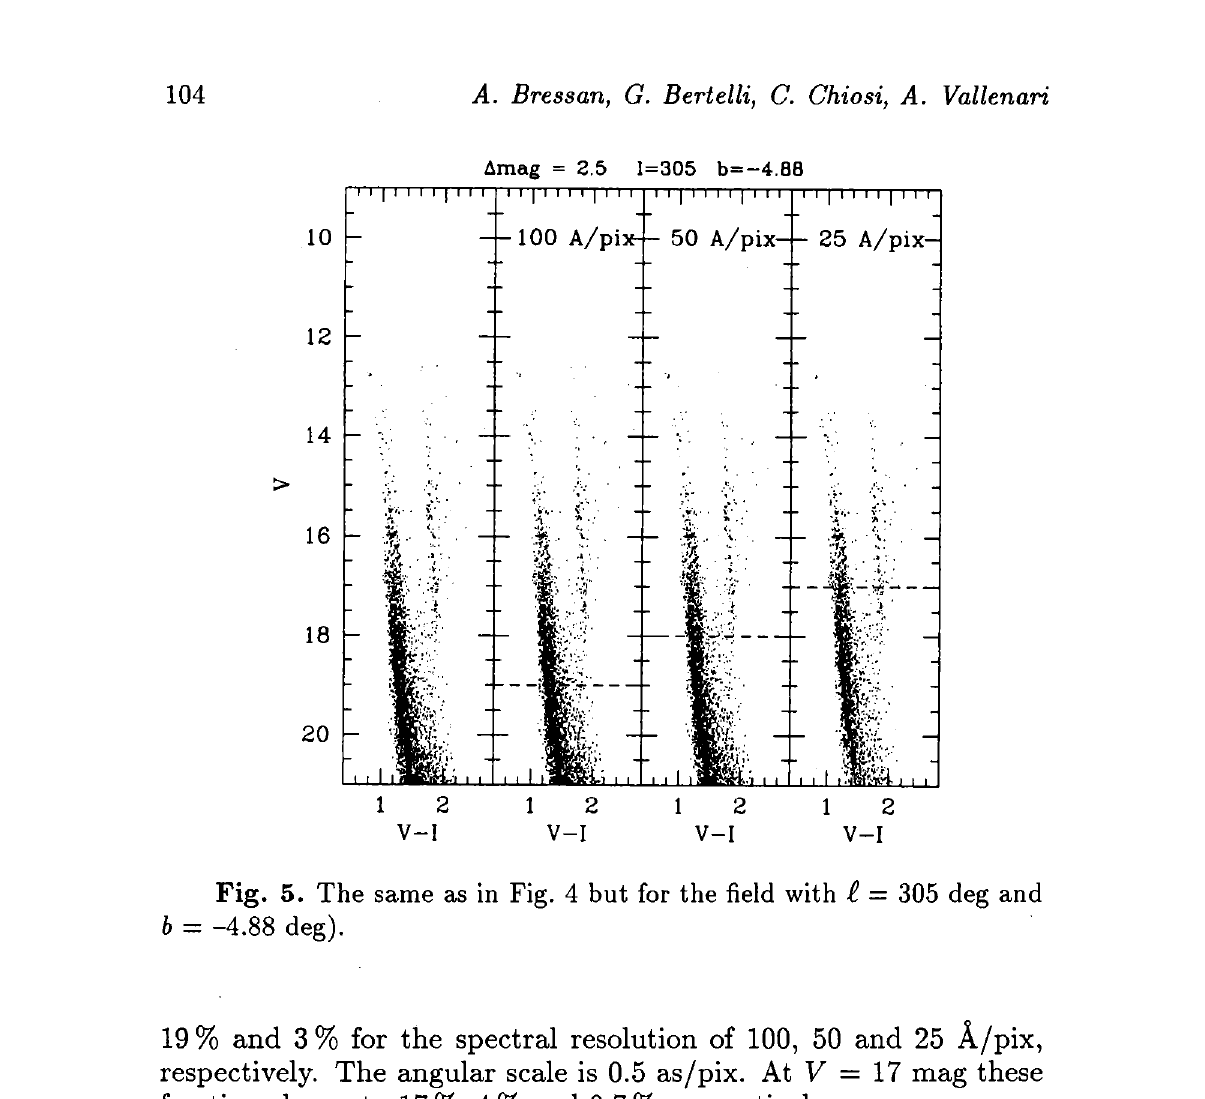
Fig. 5. The same as in Fig. 4 but for the field with I = 305 deg and b = -4.88